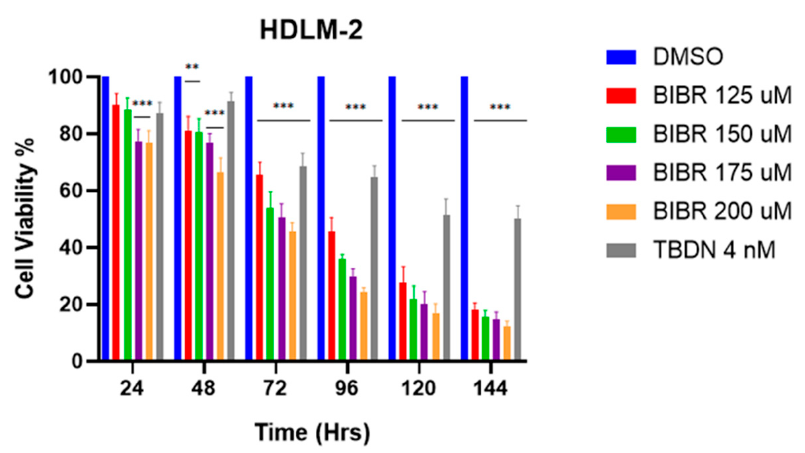
Figure A1. BIBR1532 concentration titration using HDLM-2 cell line. Decrease in cell viability upon increase in BIBR1532 concentration. The decrease in viability is time-dependent as well as dose-dependent. Data expressed as mean ± SEM. ** p < 0.01 and *** p < 0.001. TBDN—trabectedin.